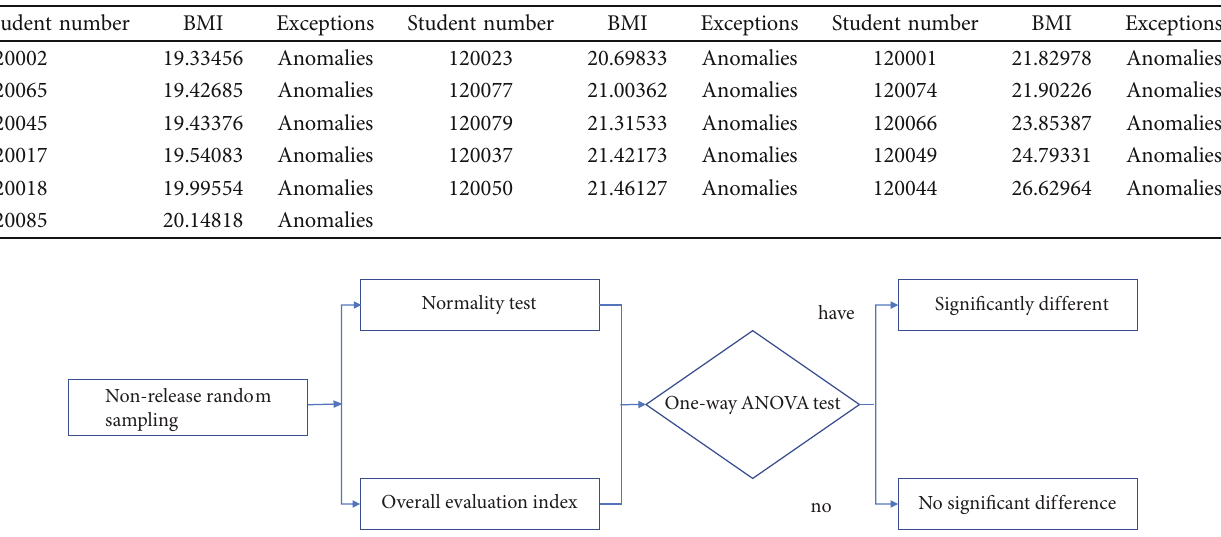
Figure 6: The idea of discriminating the signi fi cant di ff erence among the places of